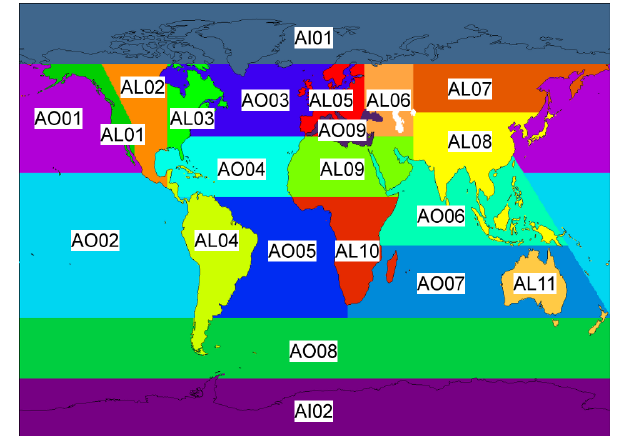
Fig. 1. Map of the 22 regions (11 land, 9 ocean, and 2 ice) over which the radiation calculations are